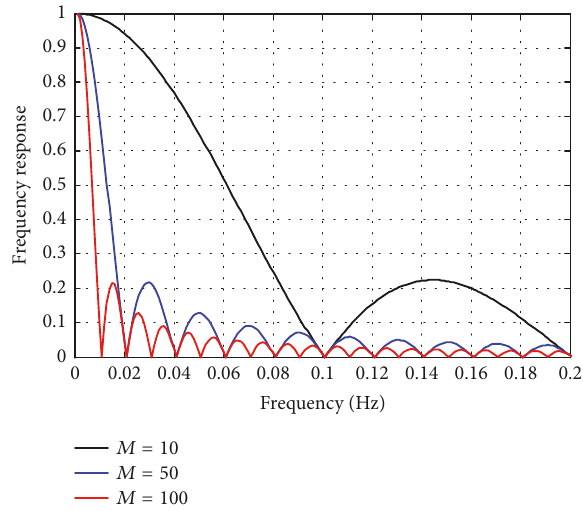
Figure 1: Frequency response of MAF using different spans 𝑀